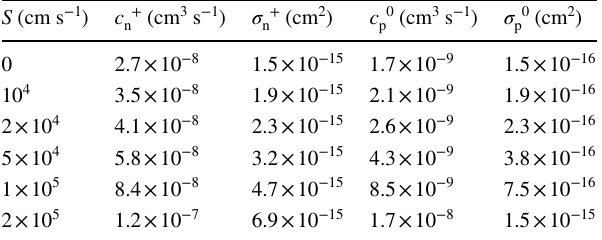
Table 2 Electron capture constant c n+ and electron capture cross sec- tion σ n+ by the positively charged color center and hole capture con- stant c p0 and hole capture cross section σ p0 by the neutral color center obtained from the experimental data using the model of the SPEL process that involves the (0) and (+ 1) charges states S (cm s −1